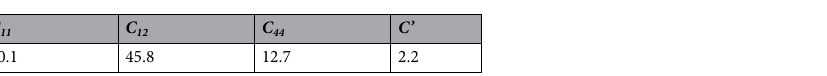
Table 1. Calculated elastic constants for ε -plutonium at an atomic volume of 24.6 Å 3 and a temperature of 900 K. C ’ = ½ ( C 11 − C 12 ) and all moduli are in units of GPa.